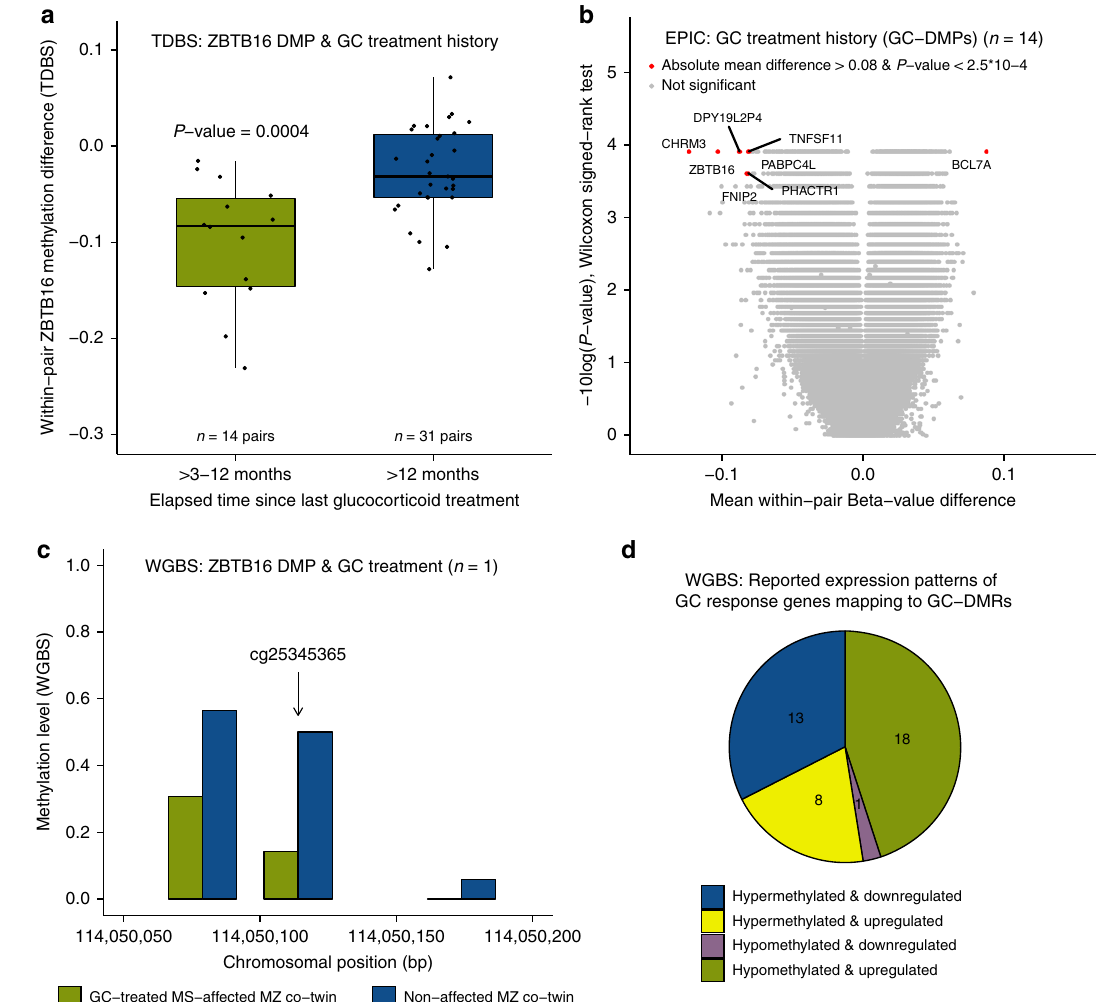
Fig. 4 Prior glucocorticoid (GC) treatment-associated DNA methylation changes. a Within-pair methylation differences of the ZBTB16 DMP (cg25345365), determined using TDBS in the 14 pairs of which the MS-affected co-twin received GCs within >3 – 12 months prior blood collection, compared to the 31 pairs of which the MS-affected co-twin was treated with GCs more than 1 year ago. Boxplots represent the median (central line), the interquartile range or IQR (bottom and top of the box), and 1.5 times the IQR (whiskers). p -value = nonparametric two-tailed Wilcoxon rank-sum test result. Source data are provided as a Source Data fi le. b Results of the differential DNA methylation analysis including only the EPIC array data of the 14 pairs of which the MS- affected co-twins received GCs >3 – 12 months prior to blood collection. The volcano plot presents the p -values resulting from the nonparametric